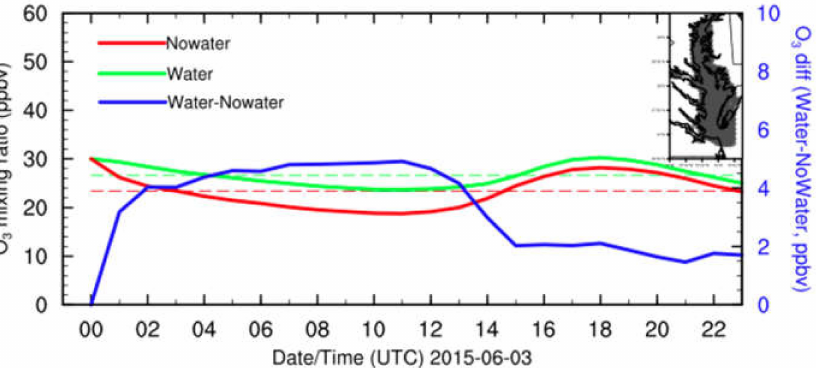
Figure 8. WRF–Chem-simulated surface O 3 mixing ratios for water (green) and nowater (red), and surface O 3 mixing ratio difference (water minus nowater, blue) diurnal variations above CB on 3 June 2015. The dashed lines are surface O 3 mixing ratio means for water (green) and nowater (red). The grey shade in the top-right corner of the map indicates the location of